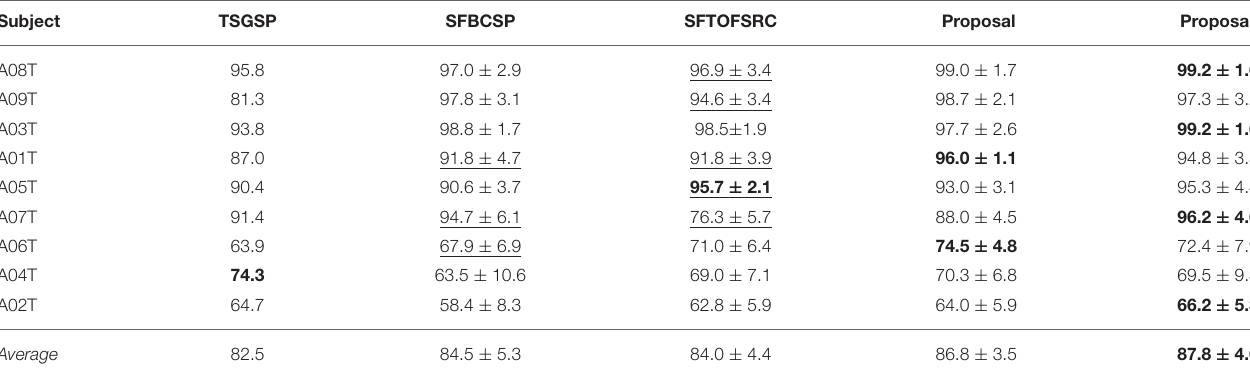
TABLE 3 | Comparison of SVM accuracy achieved by the proposed bag-level